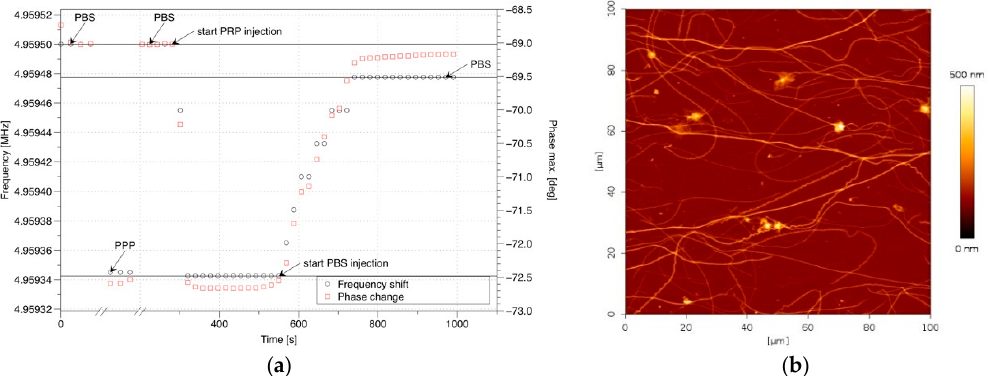
Figure 3. In-time recording of collagen immobilized sensor response (frequency and magnitude of phase maximum) during PPP/PRP injection experiment ( a ); AFM image of collagen immobilized biointerface with captured platelets ( b